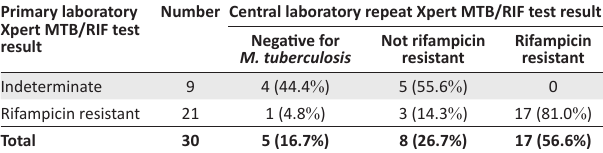
TABLE 1: Comparison of Xpert MTB/RIF testing at the primary health care facility peripheral laboratory to Xpert MTB/RIF testing at the central laboratory, Zambia, March 2012 and March